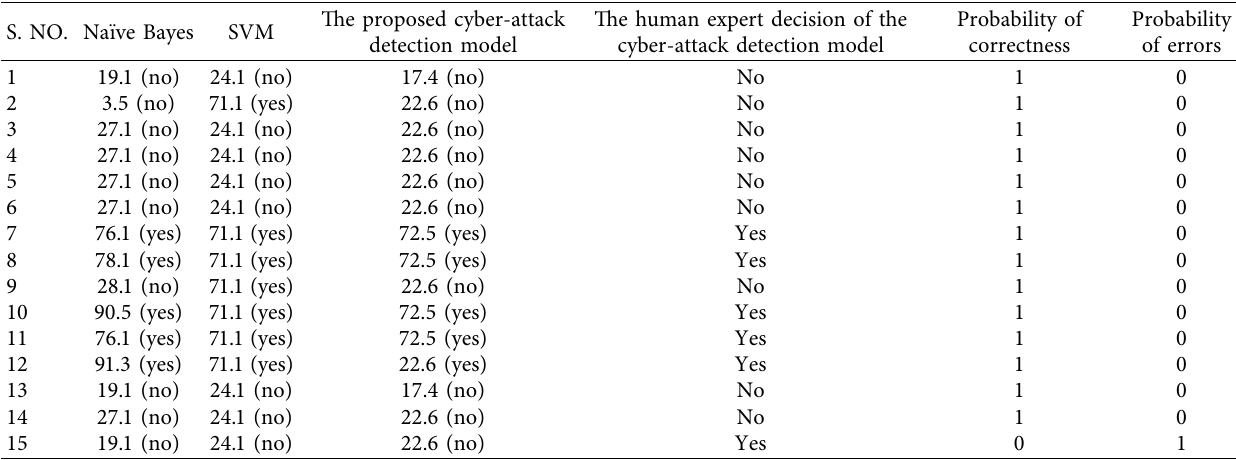
Table 7: Fusion results of the proposed cyber-attack detection model.